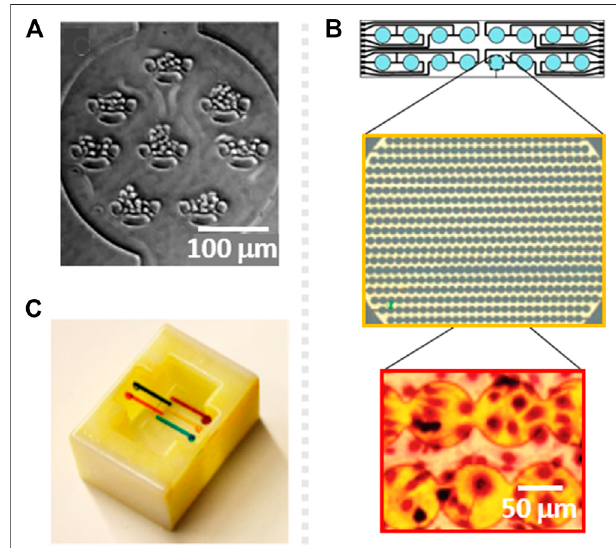
FIGURE 2 | (A) Schematic of a cytotoxicity testing microsystem with U-shapedsievesforcelladhesioncontrol,fabricatedbysoftphotolithography. Reproduced from (Wang et al., 2007) with permission from The Royal Society of Chemistry. (B) Design of an electrochemical impedance surface microelectrode array and zoomed picture of the electrodes (yellow) and the cells cultured on top (red), fabricated by electrode patterning. Reprinted with permission from (Xing et al., 2005). (C) 3D printed, reversibly pluggable micro fl uidic for toxicity screening. Reprinted with permission from (Ding et